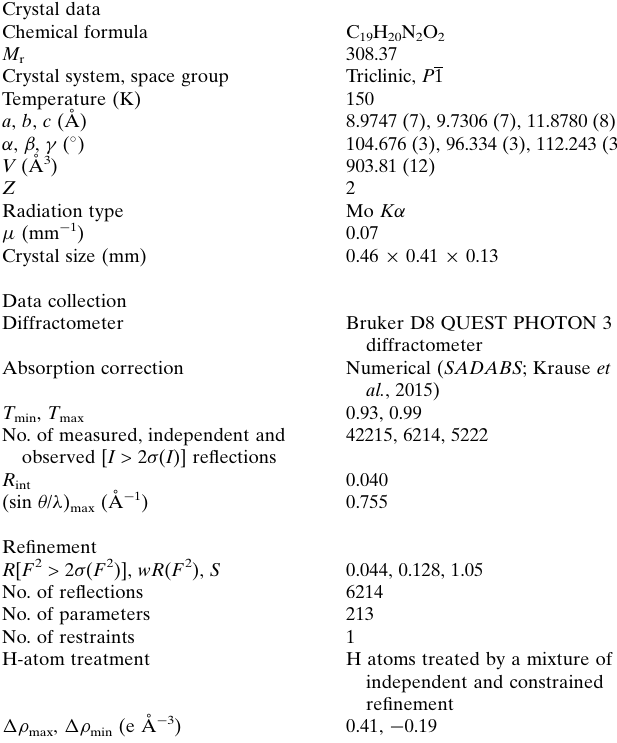
Table 2 Experimental details. Crystal data Chemical